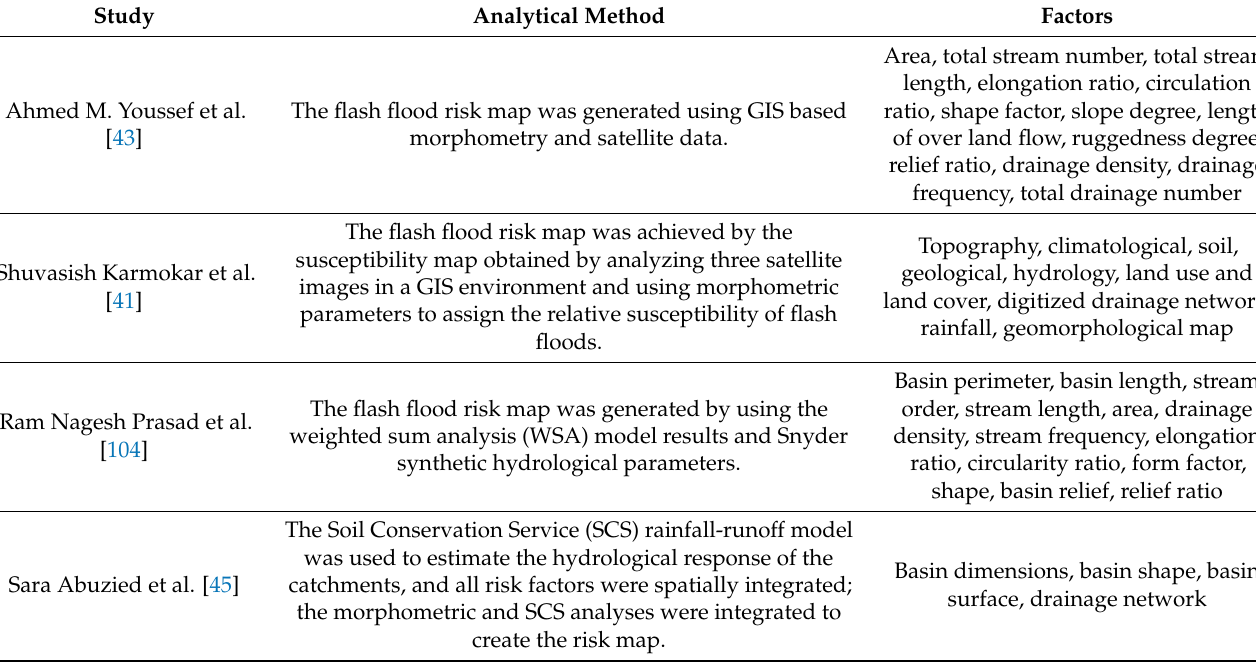
Table 6. For flash flood risk